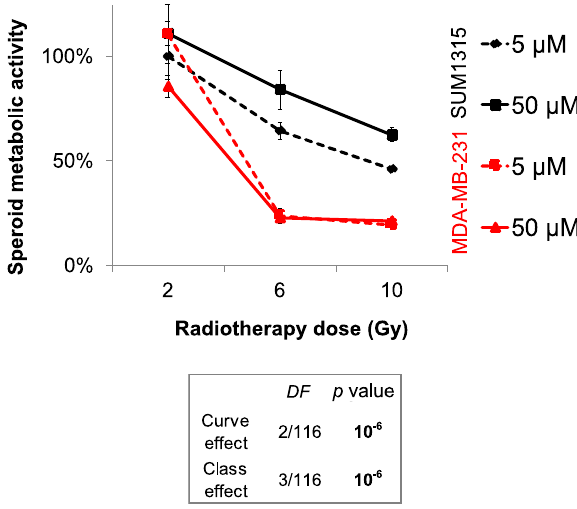
Figure 6. ANOVA analysis of spheroids sensitivity to the co-treatment with Olaparib and 2 to 10 Gy of fractioned irradiation: The decrease in spheroid metabolic activity is potentialized with 5 µ M Olaparib and heterogenous between the two MDA-MB-231 and SUM1315 cell lines. The curve e ff ect indicates a significant decrease in cell survival by the time for a same condition and the class e ff ect indicates a significant di ff erence in cell survival for a same incubation (DF = Degree of